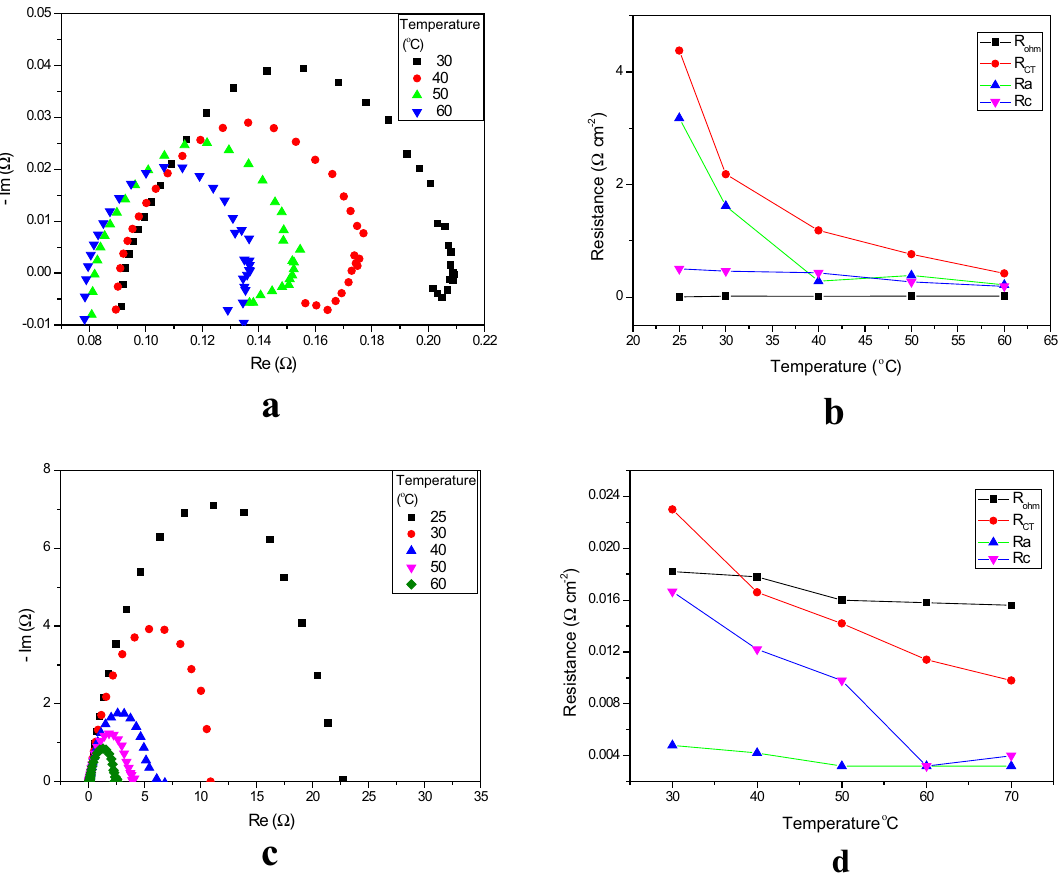
Figure 10. (a) Nyquist plots of the EIS measurements (from 100 kHz to 1 MHz) for the function of liquid electrolyte temperature at 1.5 V. ( b) Variation in the electrochemical resistances as a function of temperature at 1.5 V. ( c) Nyquist plots of the EIS measurements (from 100 kHz to 1 MHz) for the function of liquid electrolyte temperature at 1.9 V. ( d) Variation in the electrochemical resistances as a function of temperature at 1.9